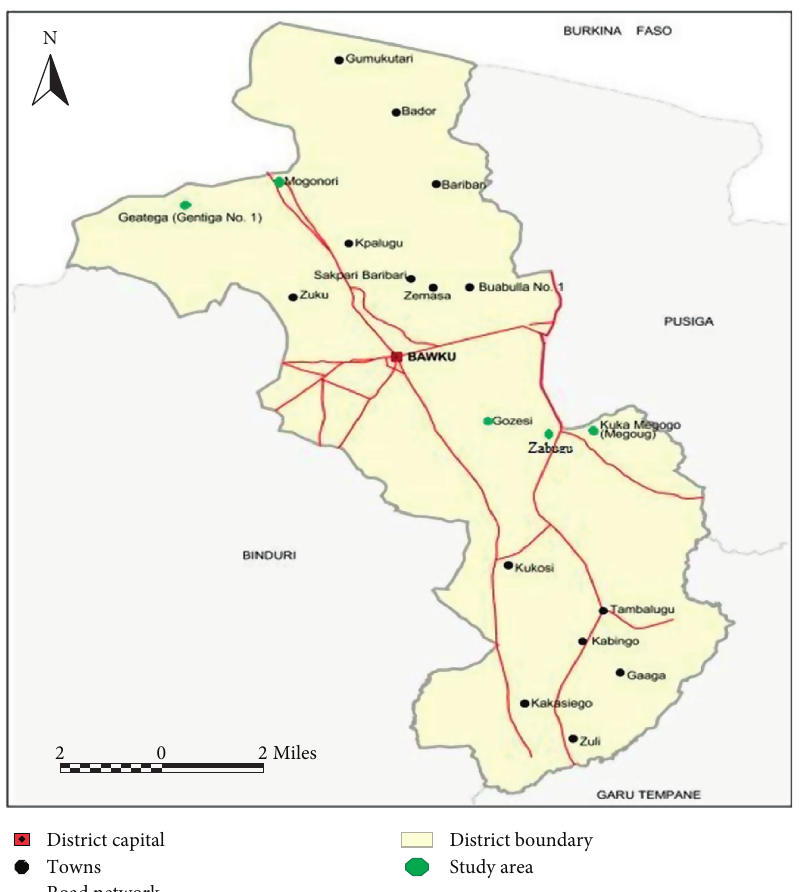
Figure 1: Map of Bawku Municipality showing the study communities (source: Bawku Municipal Assembly